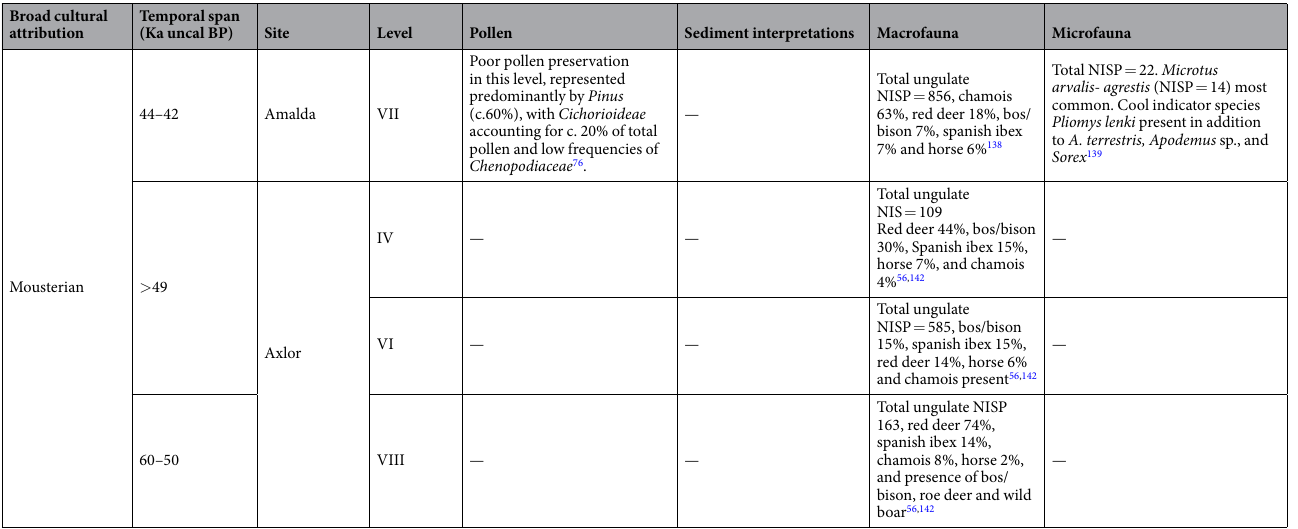
Table 4. Summary of available environmental proxies for the studied sites, including references for the information provided. Dashes denote levels where datasets are